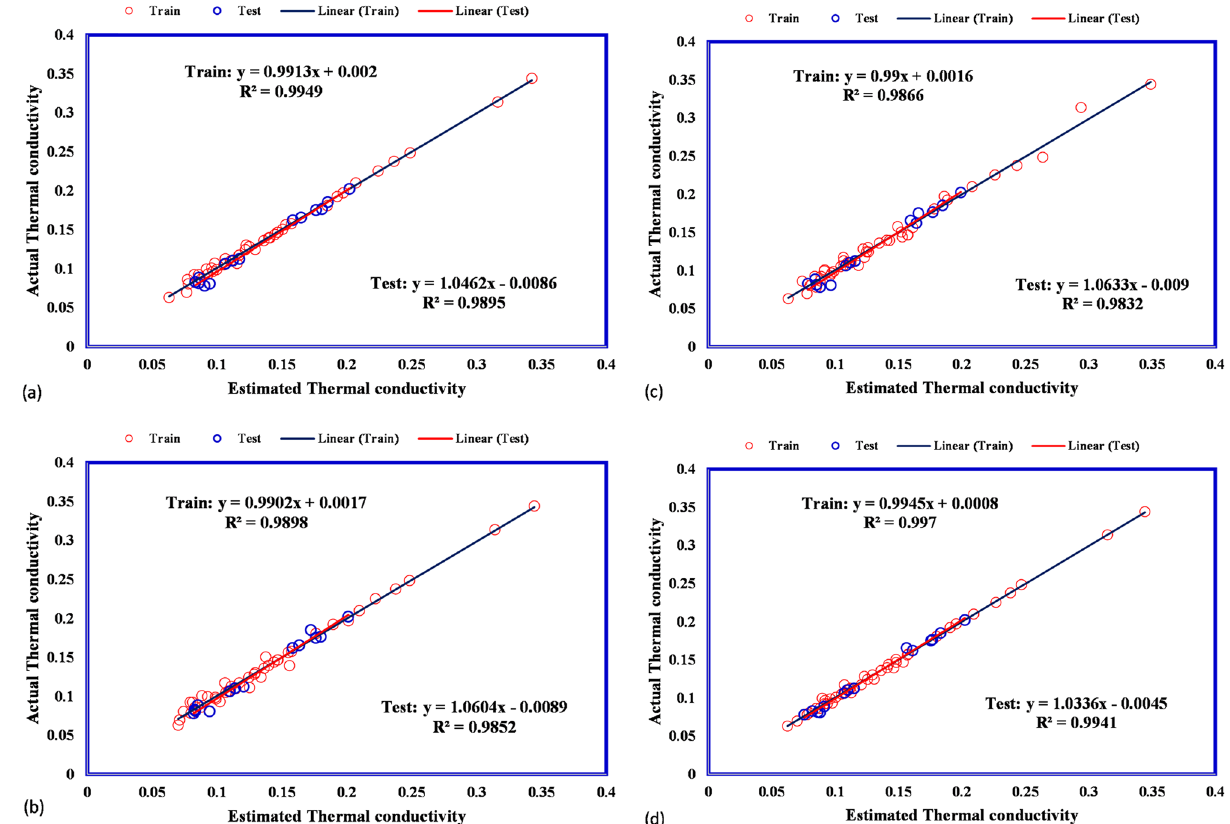
Figure 6. Cross plots for ( a ) exponential, ( b ) squared exponential, ( c ) rational quadratic, ( d )